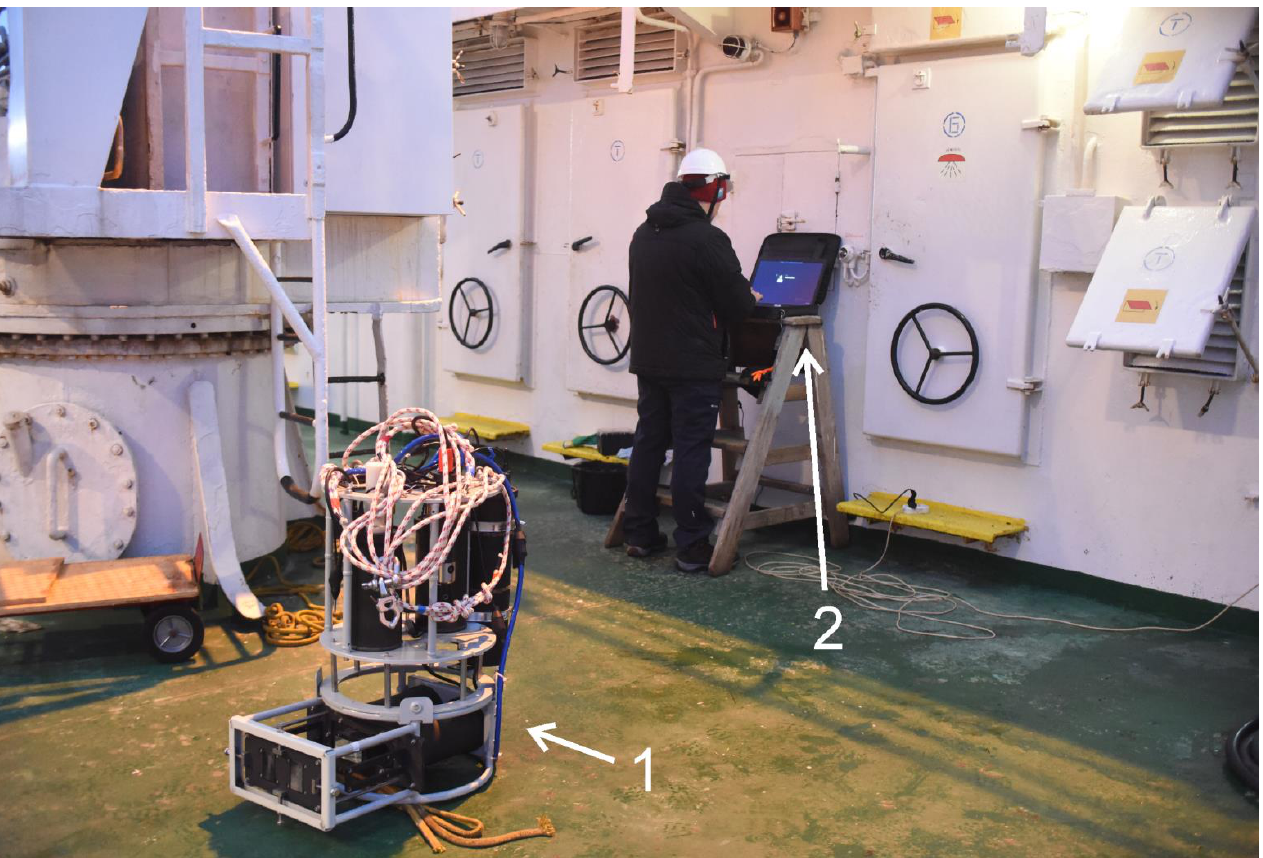
Figure 4. A hydrobiological DHC probe in combination with hydrophysical sensors of tempera- ture, conductivity, and pressure on the deck of the Academician Mstislav Keldysh (1). Operator’s workstation for data acquisition and processing (2).